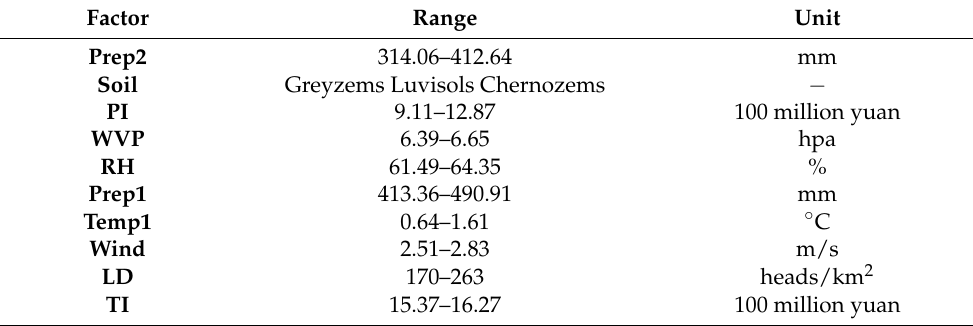
Table 4. Suitable threshold range of dominant driving